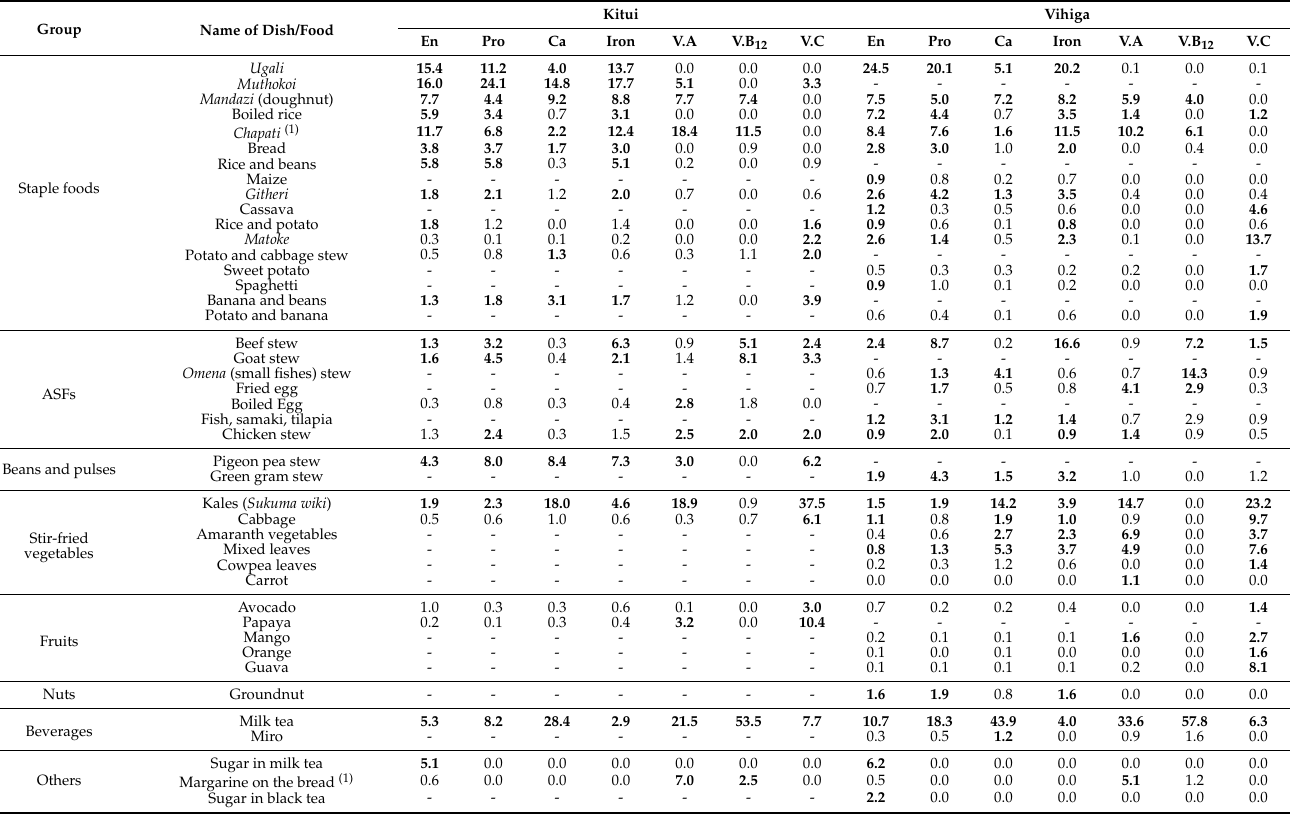
Table 5. Contribution rate to total nutrient intake of each dish/food in farm women in charge of meal